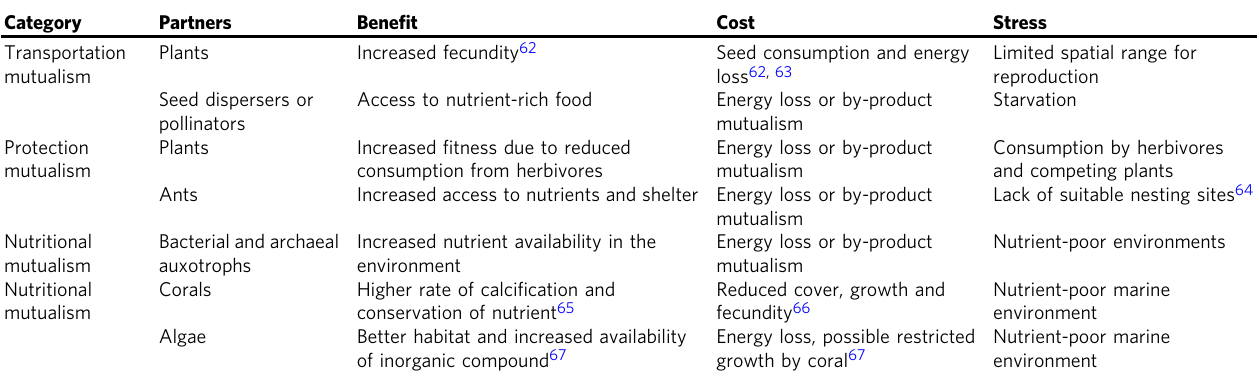
Table 1 Examples of bene fi t, cost, and stress in diverse mutualistic